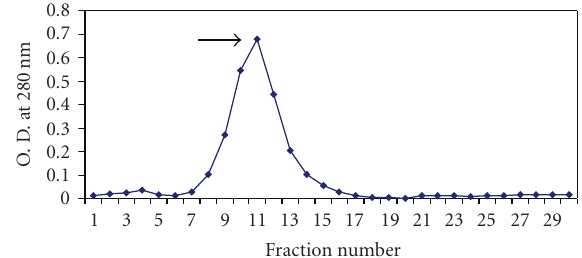
Figure 1: Elution pattern of sperm immobilization factor from E. coli on Sephadex G-100 column.